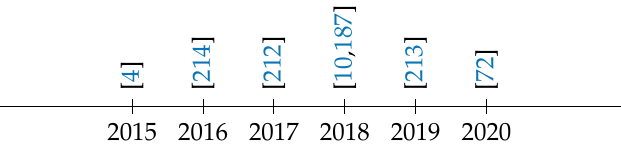
Figure 14. A timeline of different papers within the ethical and legal implications theme.